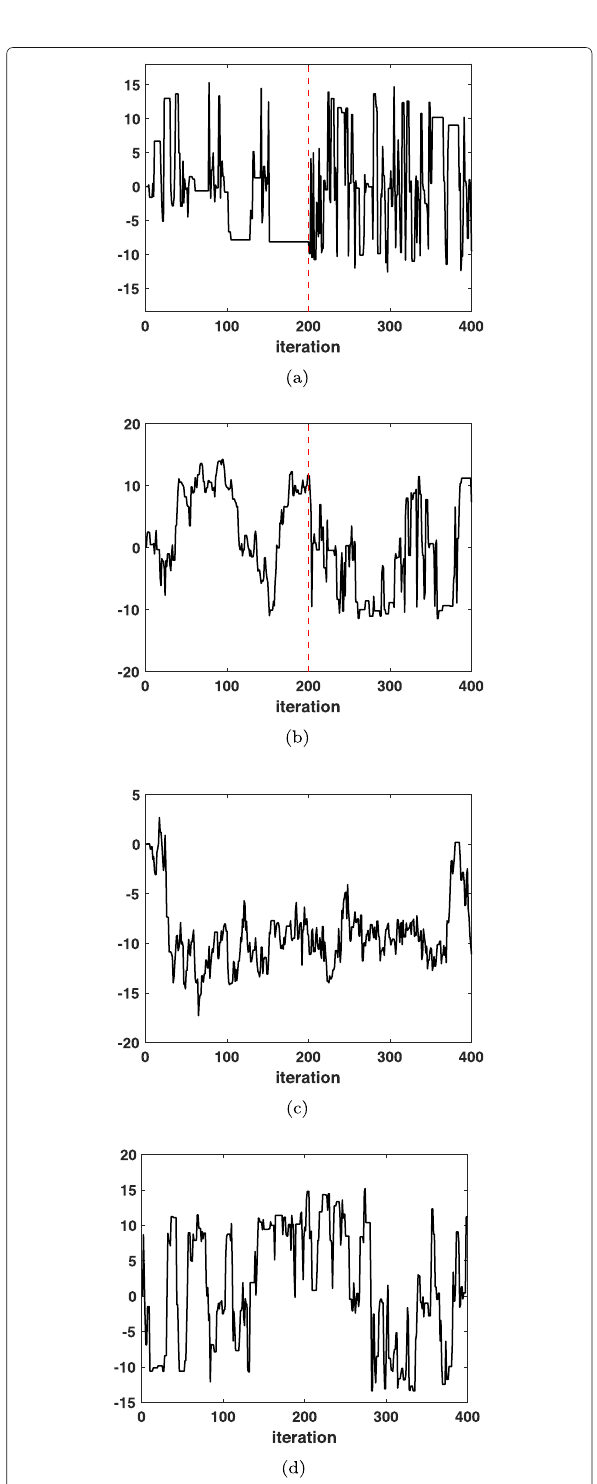
Fig. 2 Trace plots for the univariate Gaussian target in Section 6.1 with M = 3. a AGM-MH algorithm. b AM algorithm. The red dashed line in ( a ) and ( b ) marks the beginning of the adaptation period. c Random walk MH with σ = 2. d Random walk MH with σ =